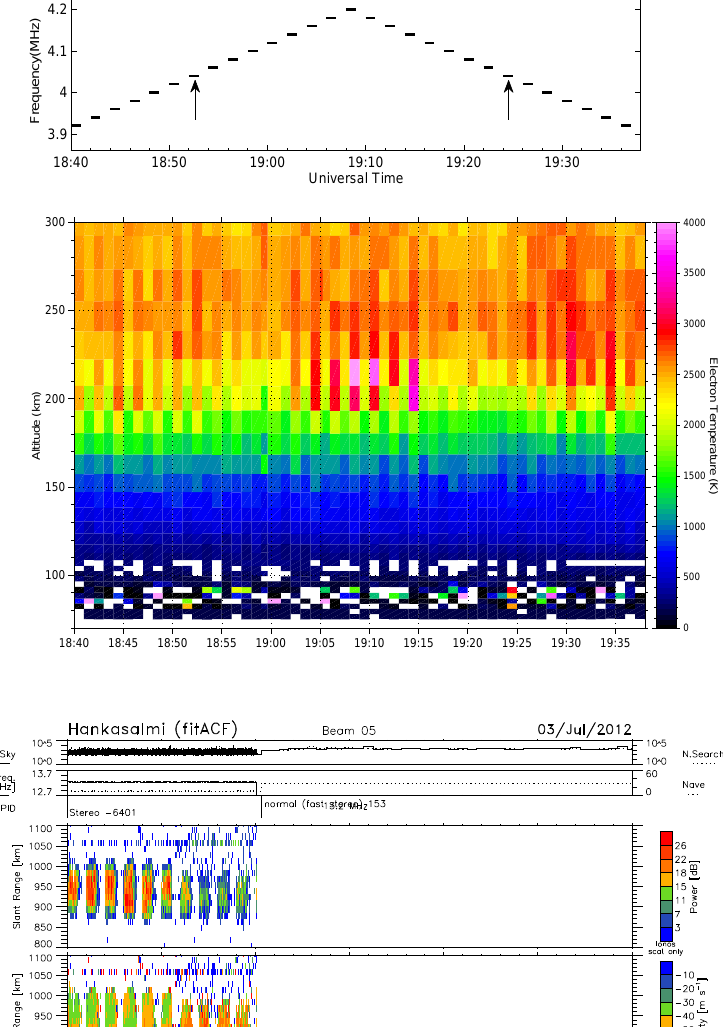
pump frequency near 3 f c e (i.e. f 0 = 4 . 04 MHz). The